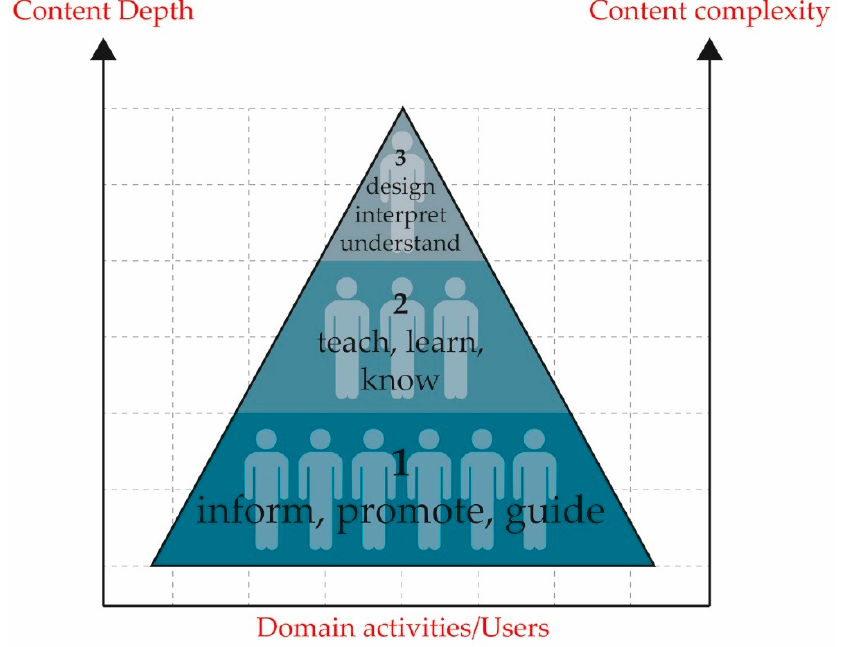
Figure 6. Graphical diagram with the AR aims related to content depth/complexity, and referring to the domain activities/users of the AR